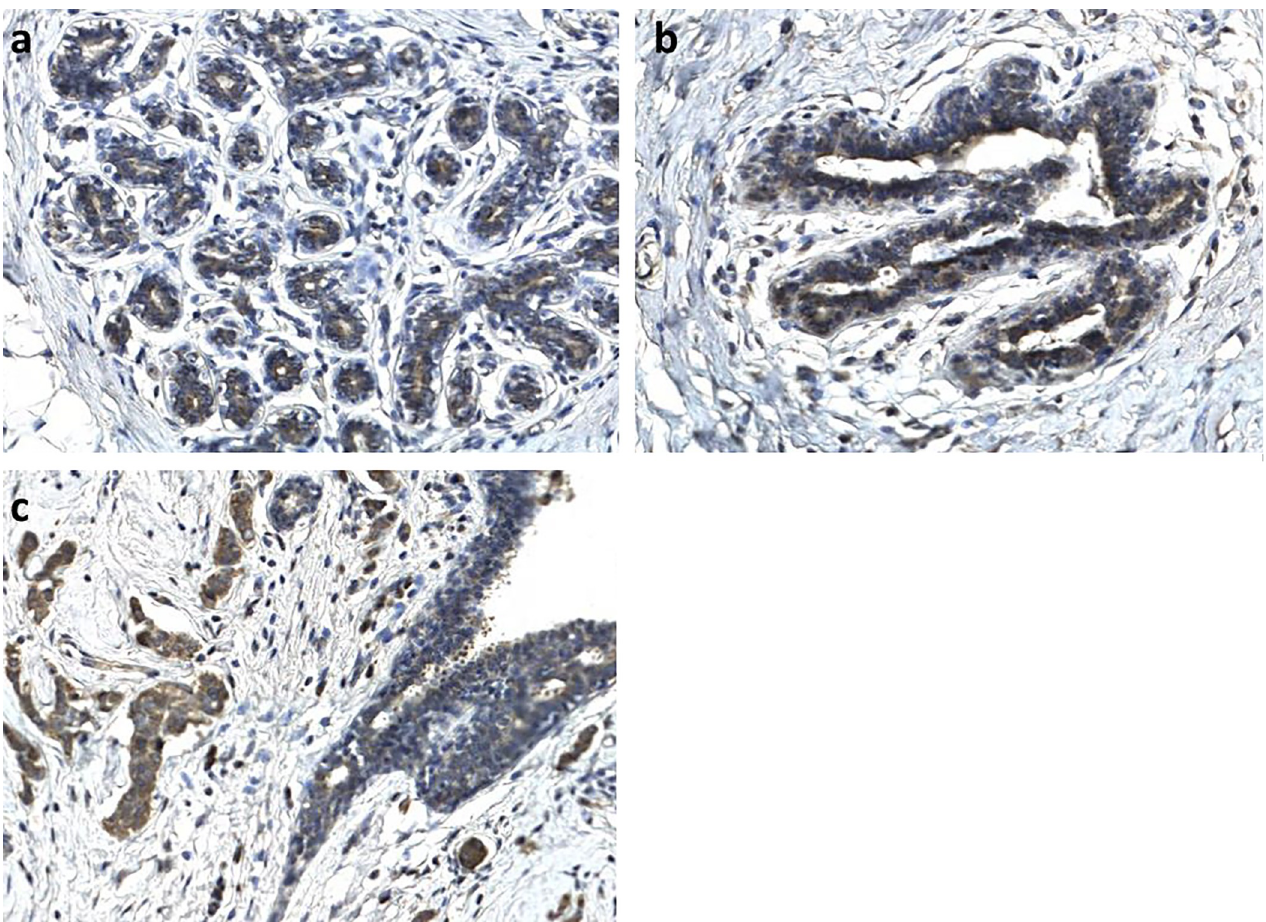
Fig 2. Expression of eEF1A2 in normal breast parenchyma. a: expression in acinar cells; b: expression in ductal cells; c: weak (1+) expression in normal ductal cells used to calibrate staining intensity in cancer cells (2+). 20x magnification.